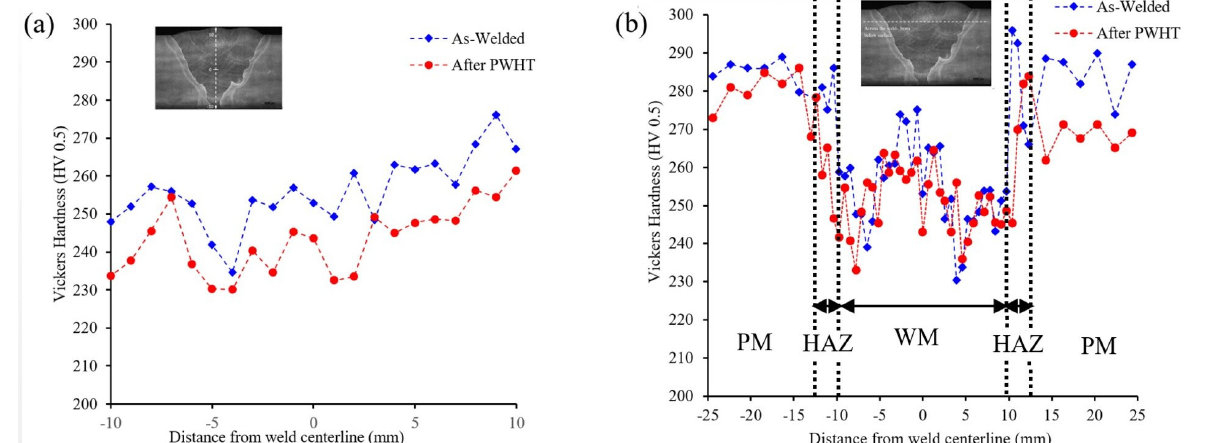
Figure 4. Microhardness distribution for the as-welded and PWHT specimens ( a ) through the thick- ness at the centreline, and ( b ) 3 mm below the surface across the weld. thickness at the centreline, and ( b ) 3 mm below the surface across the